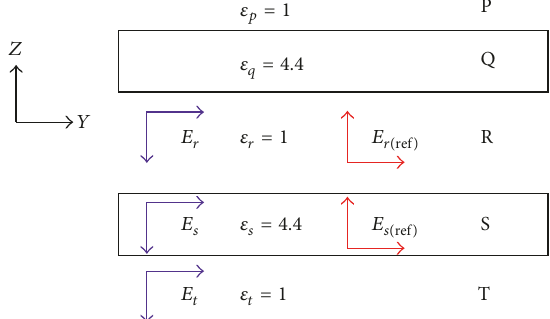
Figure 9: Plane wave incident and reflection in context to reflector.